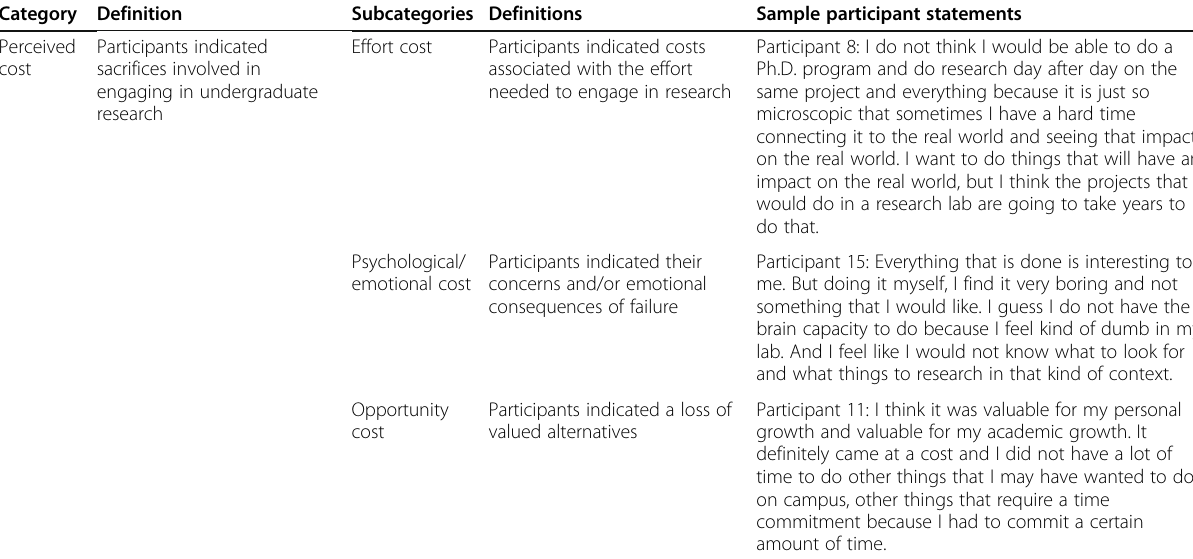
Table 5 Definitions of the perceived costs, subcategories, and examples of participants ’ statements Category